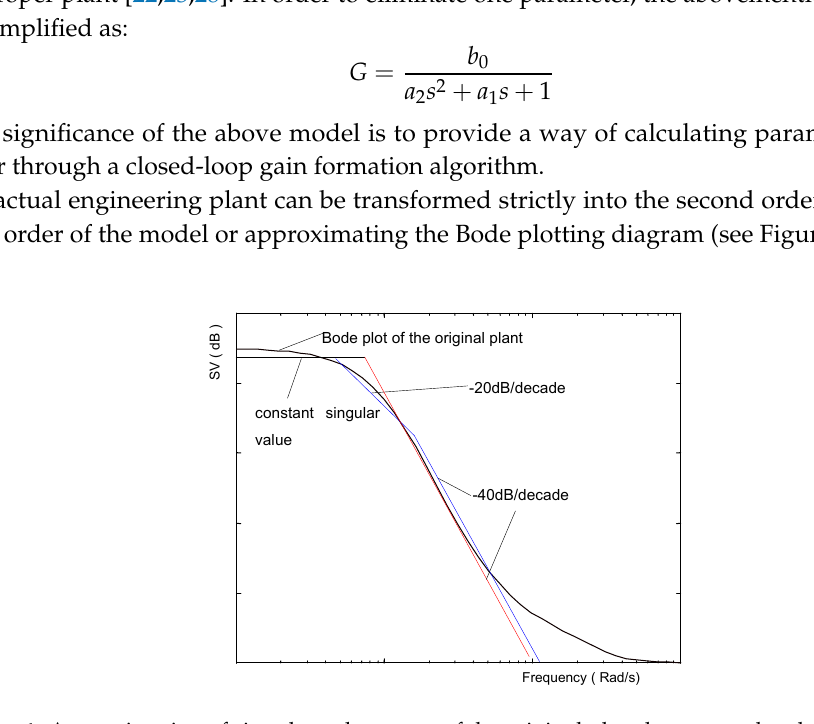
Figure 1. Approximation of singular value curve of the original plant by a second-order deep strictly proper plant .